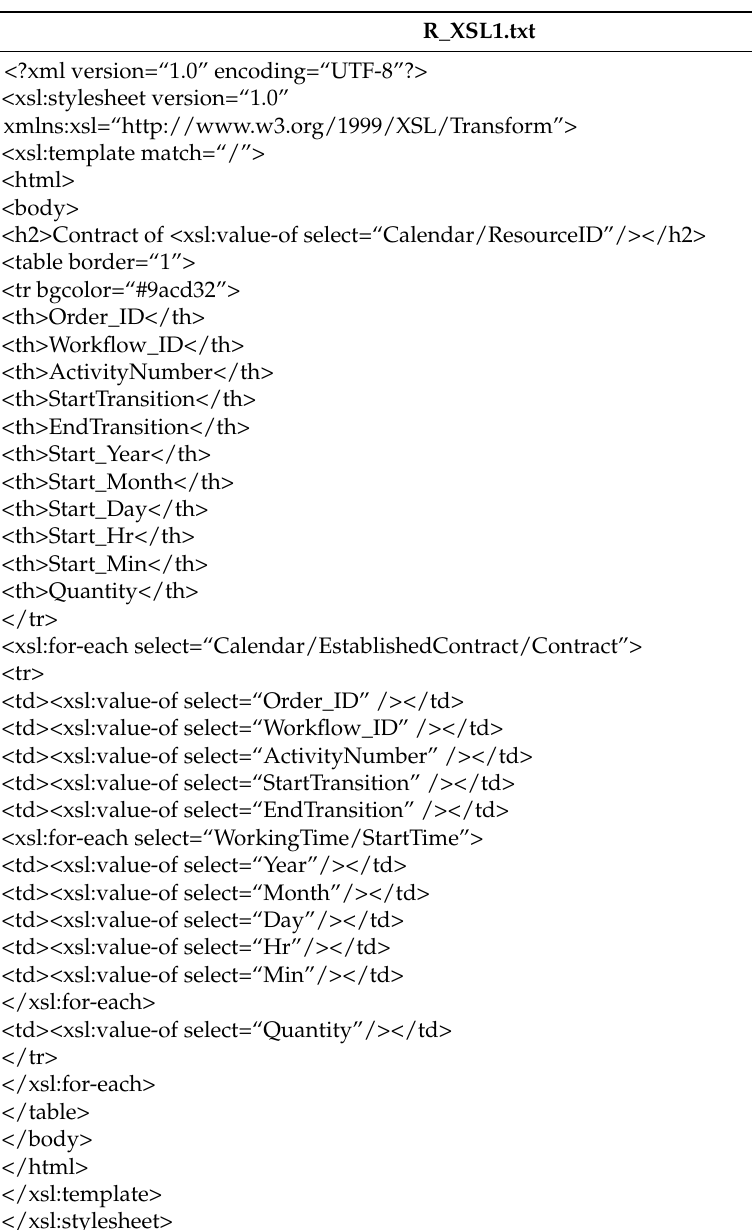
Table 5. The XSLT code of Example